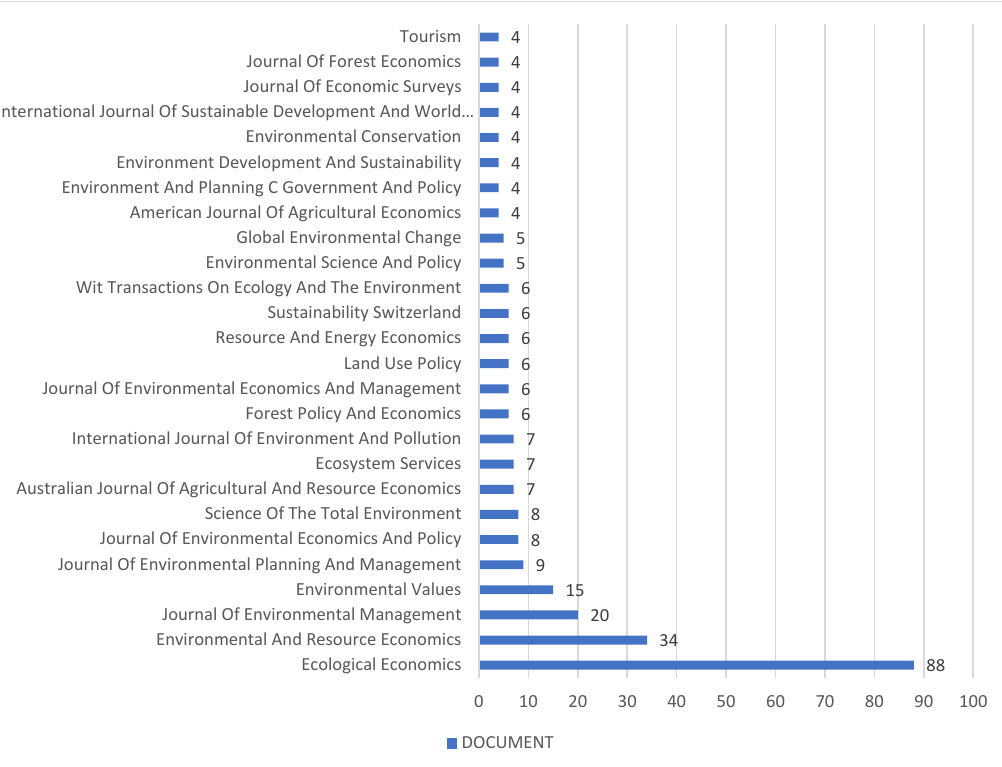
Table 3. Citations and strength of journal publications on environmental valuation research. Research Outlet